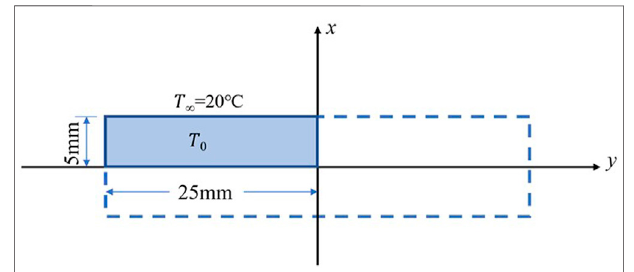
FIGURE 3 | Geometric schematic diagram of the rectangular ceramic